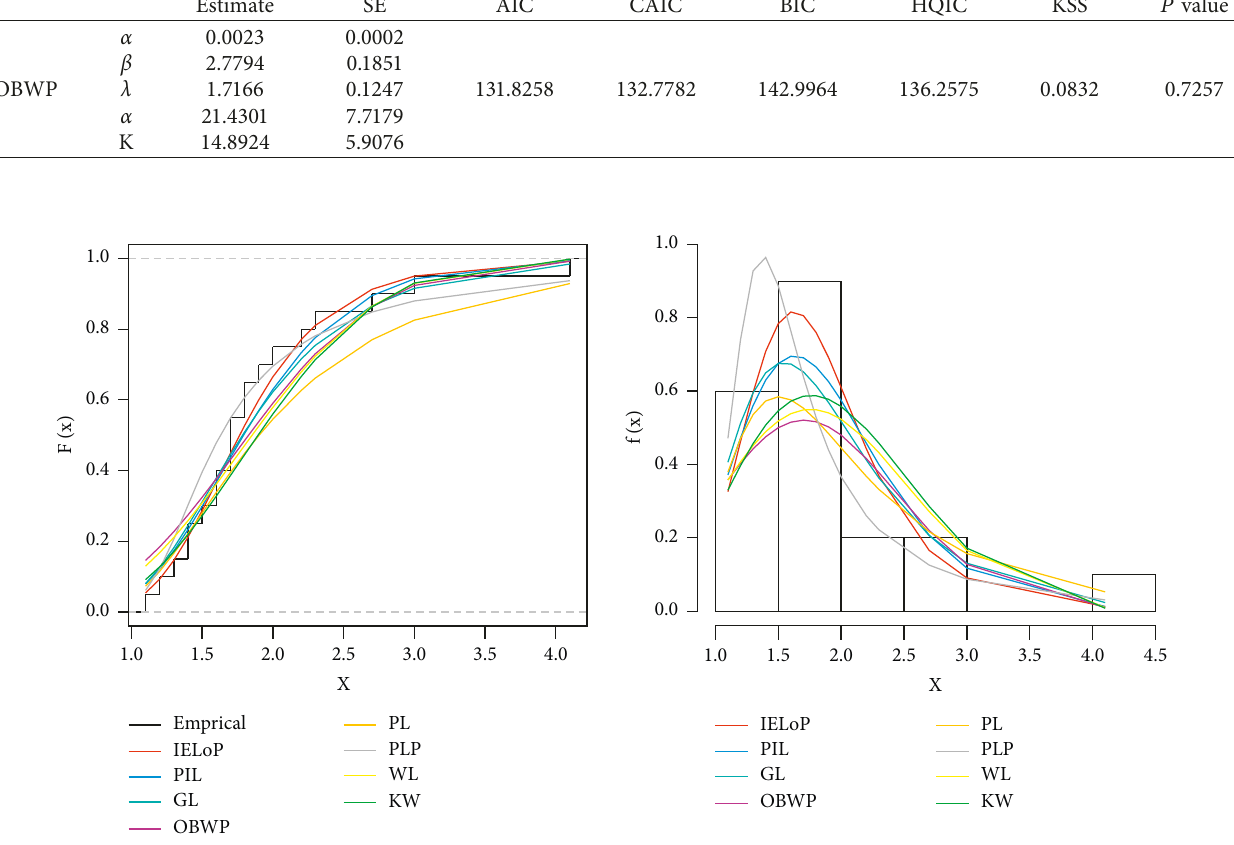
Figure 4: Estimated cdf and pdf for different distributions for dataset I.